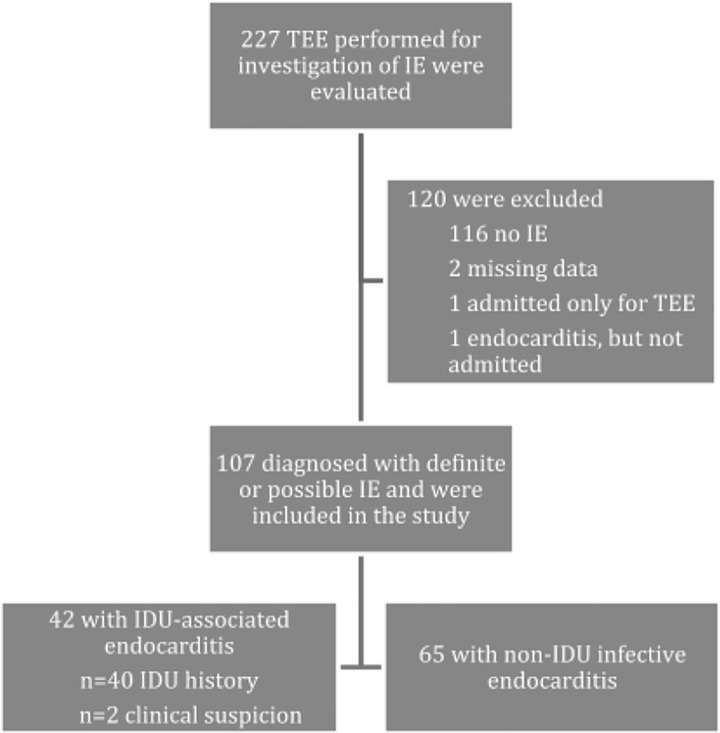
Patient selection: Patients who received transesophageal echocardiography (TEE) for investigation of injection drug use (IDU)-associated infective endocarditis (IE).